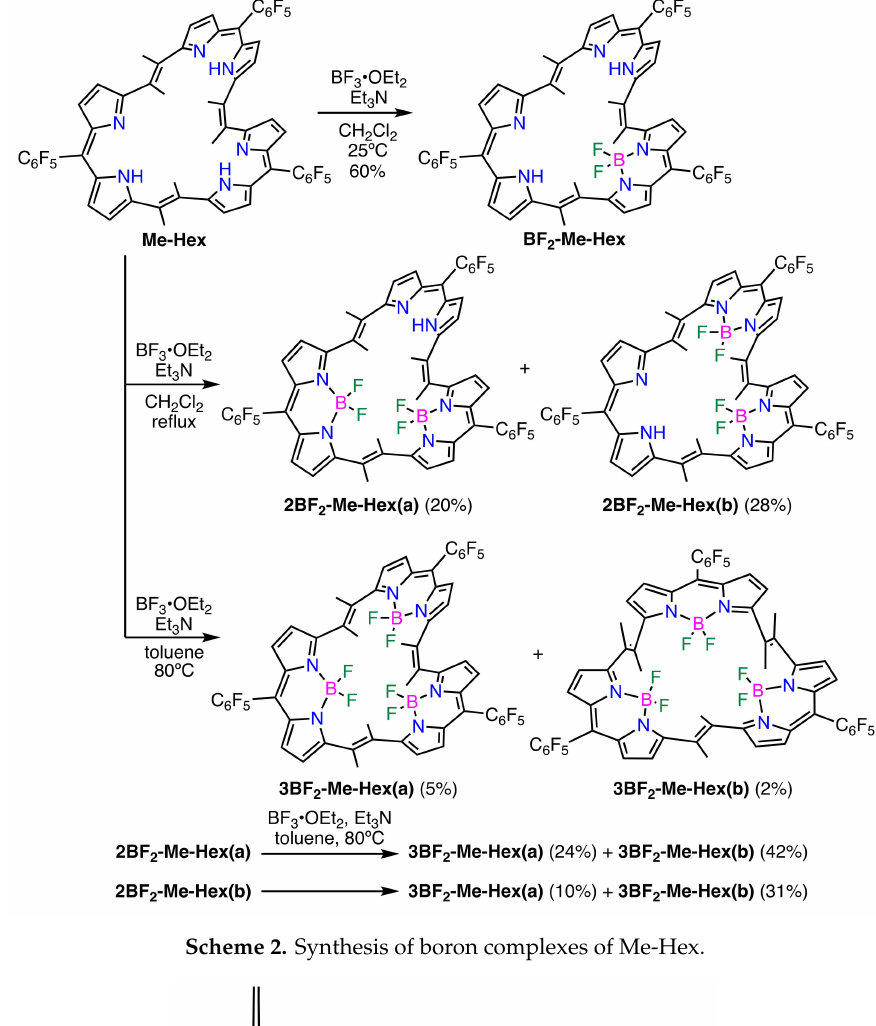
Scheme 2. Synthesis of boron complexes of Me-Hex.